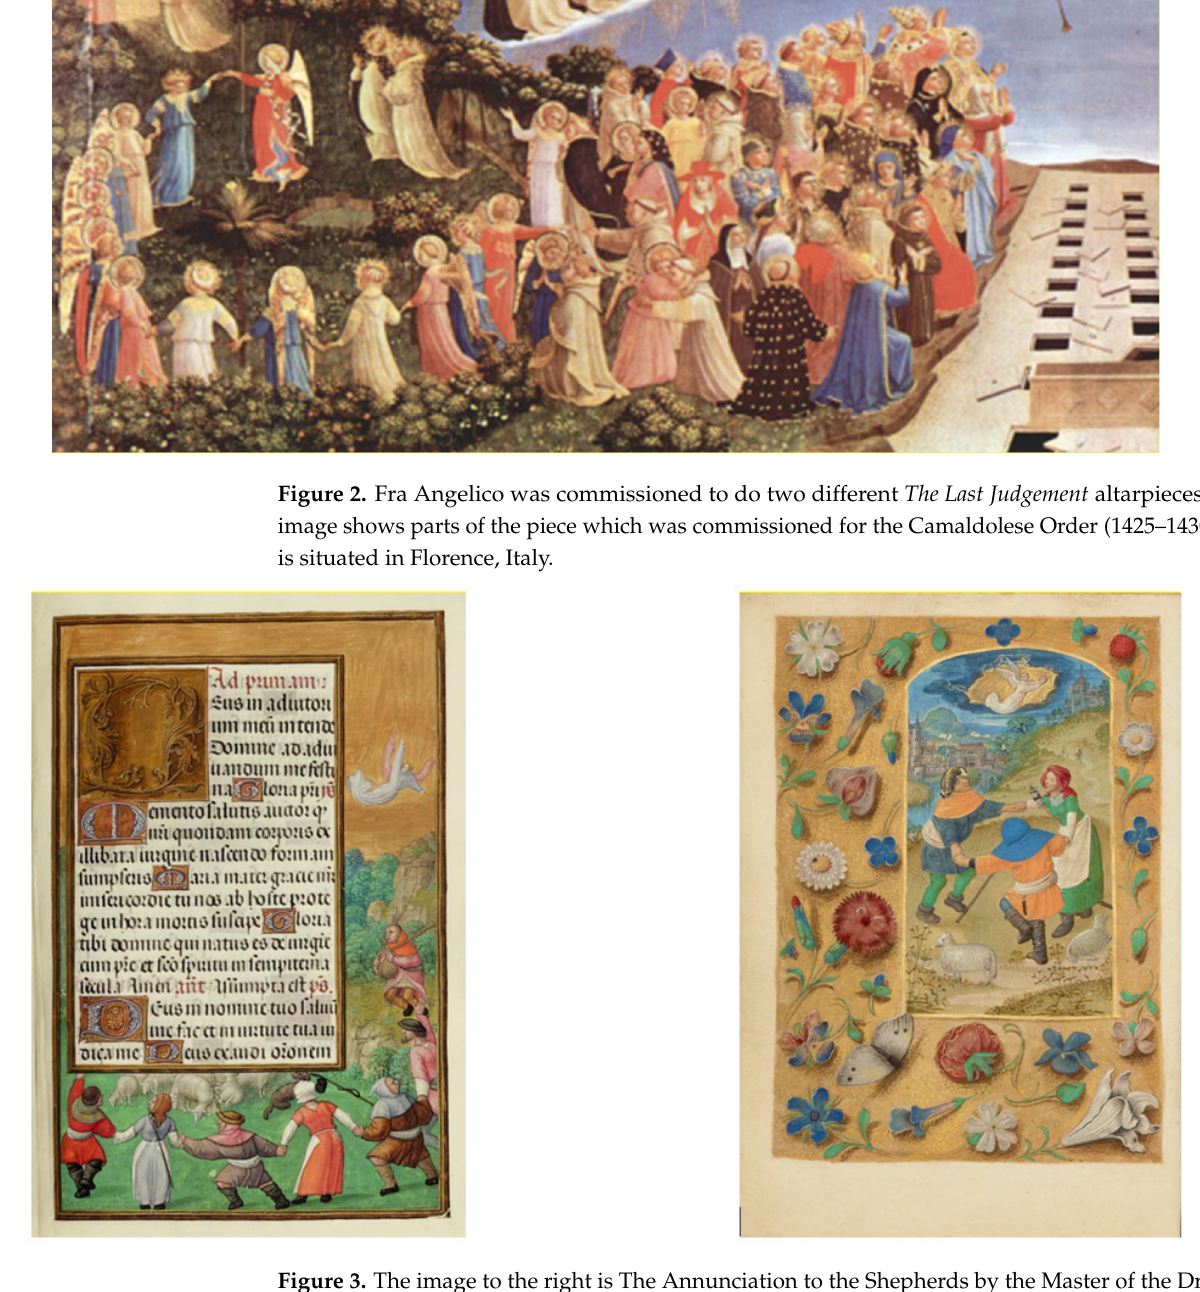
Figure 3. The image to the right is The Annunciation to the Shepherds by the Master of the